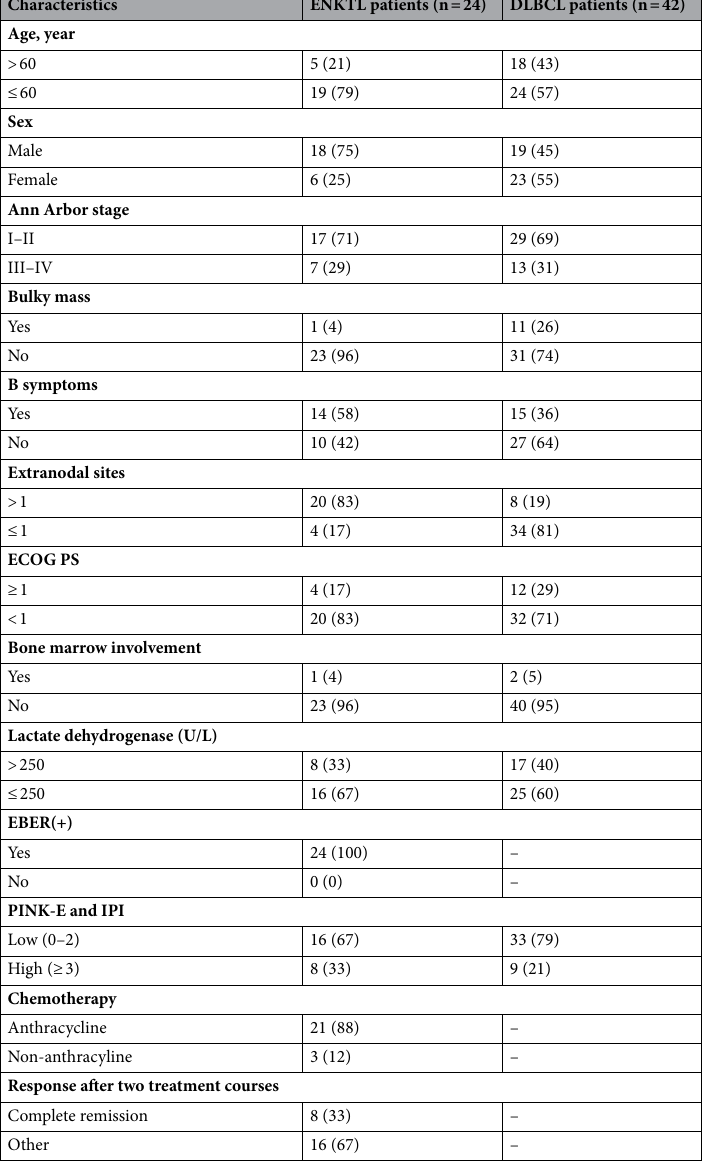
Table 1. Baseline and clinical characteristics of 66 patients. Values are n (%). DLBCL diffuse large B-cell lymphoma, ECOG PS Eastern Cooperative Oncology Group performance score, ENKTL extranodal natural killer/T-cell lymphoma, PINK-E prognostic index of extranodal natural killer/T-cell lymphoma, IPI international prognostic index, “–” data not